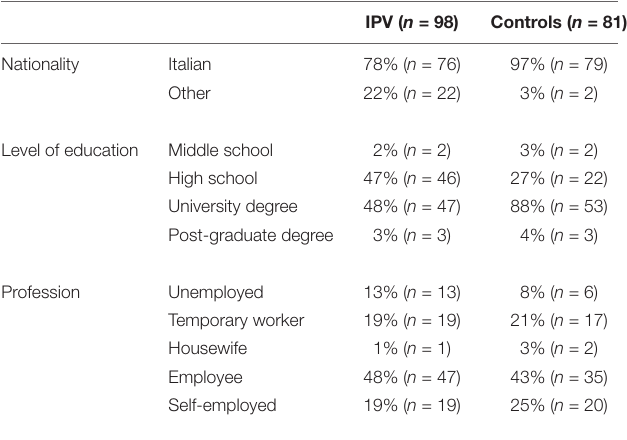
TABLE 1 | Socio-demographic